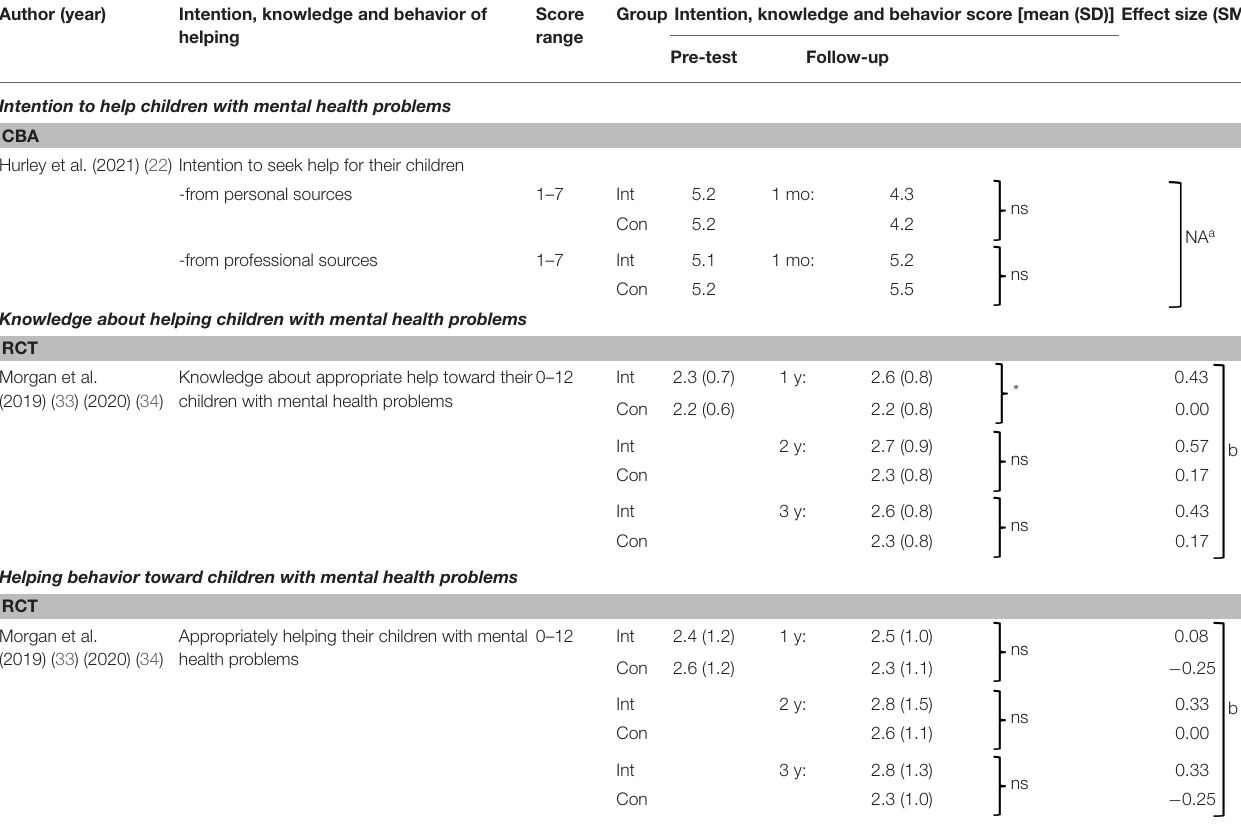
TABLE 7 | Effects on intention, knowledge and behavior of helping children with mental health problems. Author (year) Intention, knowledge and behavior of